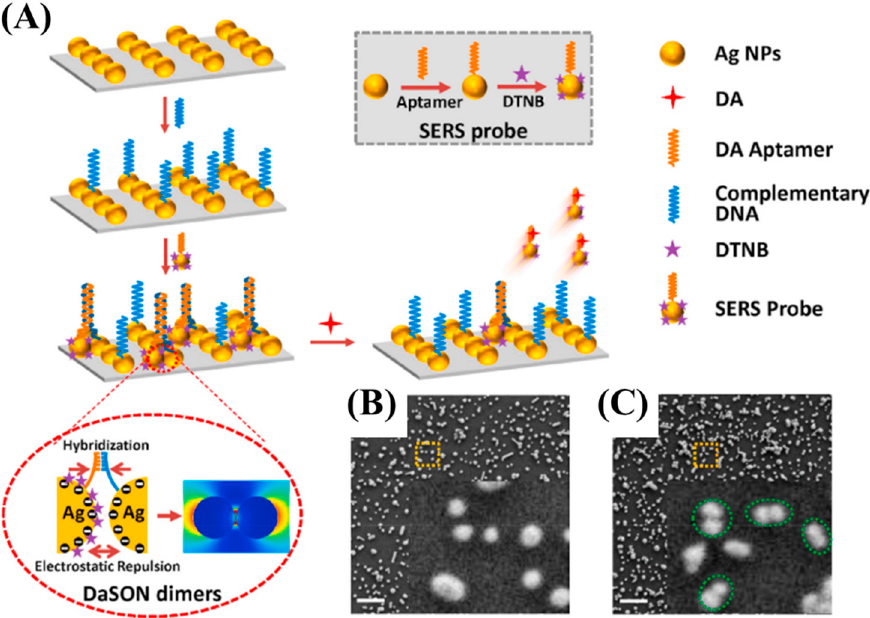
Figure 8. ( A ) Schematic diagram of Raman detection of dopamine (DA) using DNA-assisted synthesis of ortho-nanodimers (DaSON) of AgNPs. SEM images of Raman platforms with a scale bar of 500 nm ( B ) before and ( C ) after the adsorption of Raman probes containing DA aptamers and DTNB. Inserted pictures show an enlarged view of the yellow rectangle. Adapted from [104].